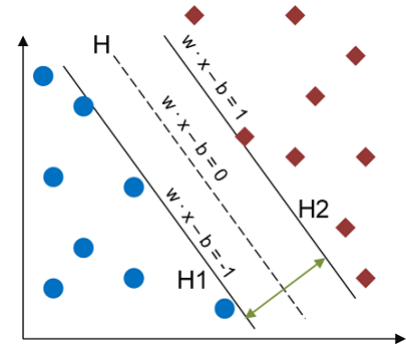
Figure 3. Hyperplane and parallel H1 and H2 hyperplanes that separate classes while maintaining the maximum margin [53], modified.